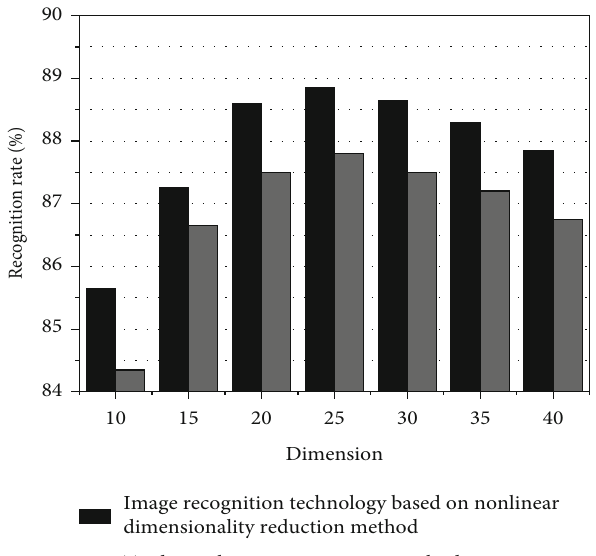
Figure 4: Comparison of recognition results under di ff erent feature